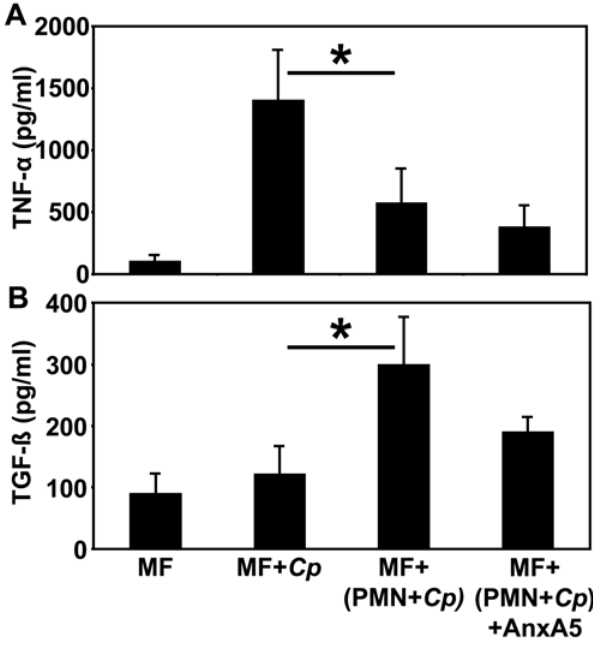
Figure 7. Silencing of MF immune response to chlamydial infection by PMN passage. Immune responses of directly C. pneumoniae - infected MF were analyzed in comparison to MF either co incubated with C. pneumoniae - infected PMN (66 h p.i.) or with C. pneumoniae - infected PMN after precinubation with recombinant AnxA5. Within 18 h p.i. supernatants of MF were collected to determine total amounts of TNF- a (A) and TGF-ß (B) by ELISA. Direct infection of MF with C. pneumoniae significantly increased TNF- a production ( A , p=0.01; n=3), whereas the uptake of C. pneumoniae - infected apoptotic PMN was characterized by a significant up regulation of TGF-ß in MF ( B , p=0.02; n=3).